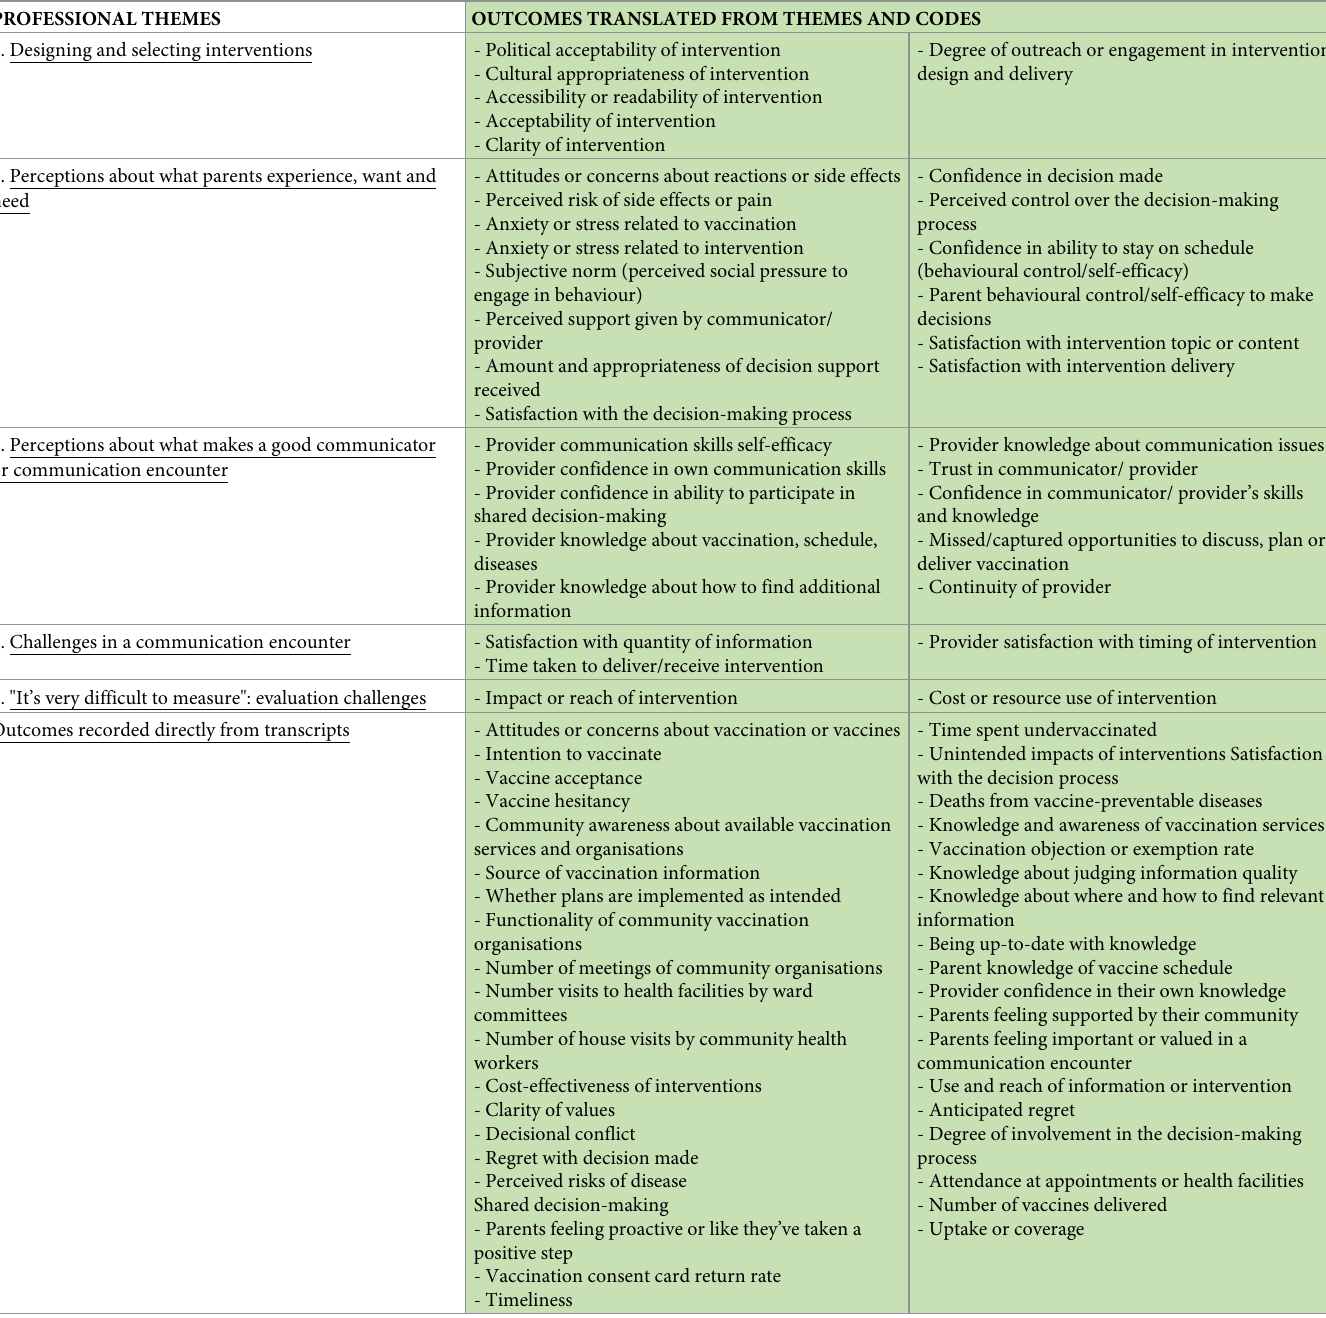
Table 3. Professional themes and translated